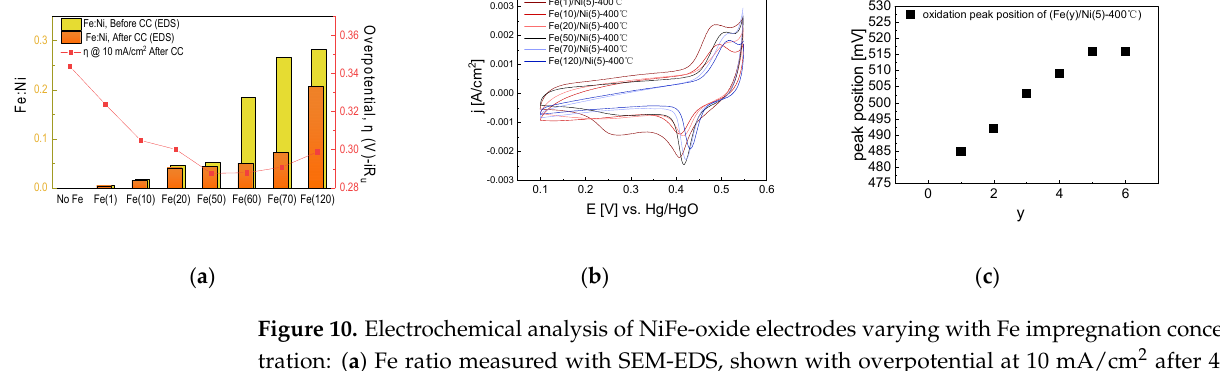
CC (1.5 A/cm 2 ) operation, ( b ) CV cycles of NiFe-oxide electrodes after 4 h CC operation. ( c ) CV